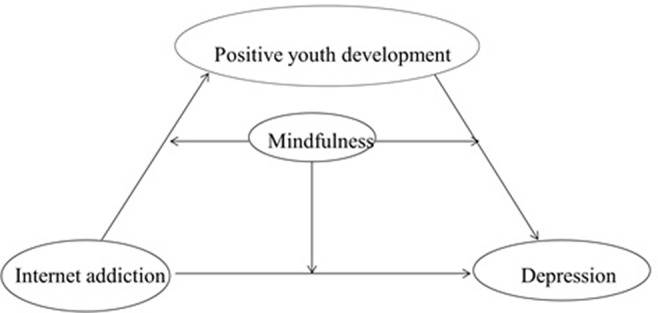
Conceptual model.